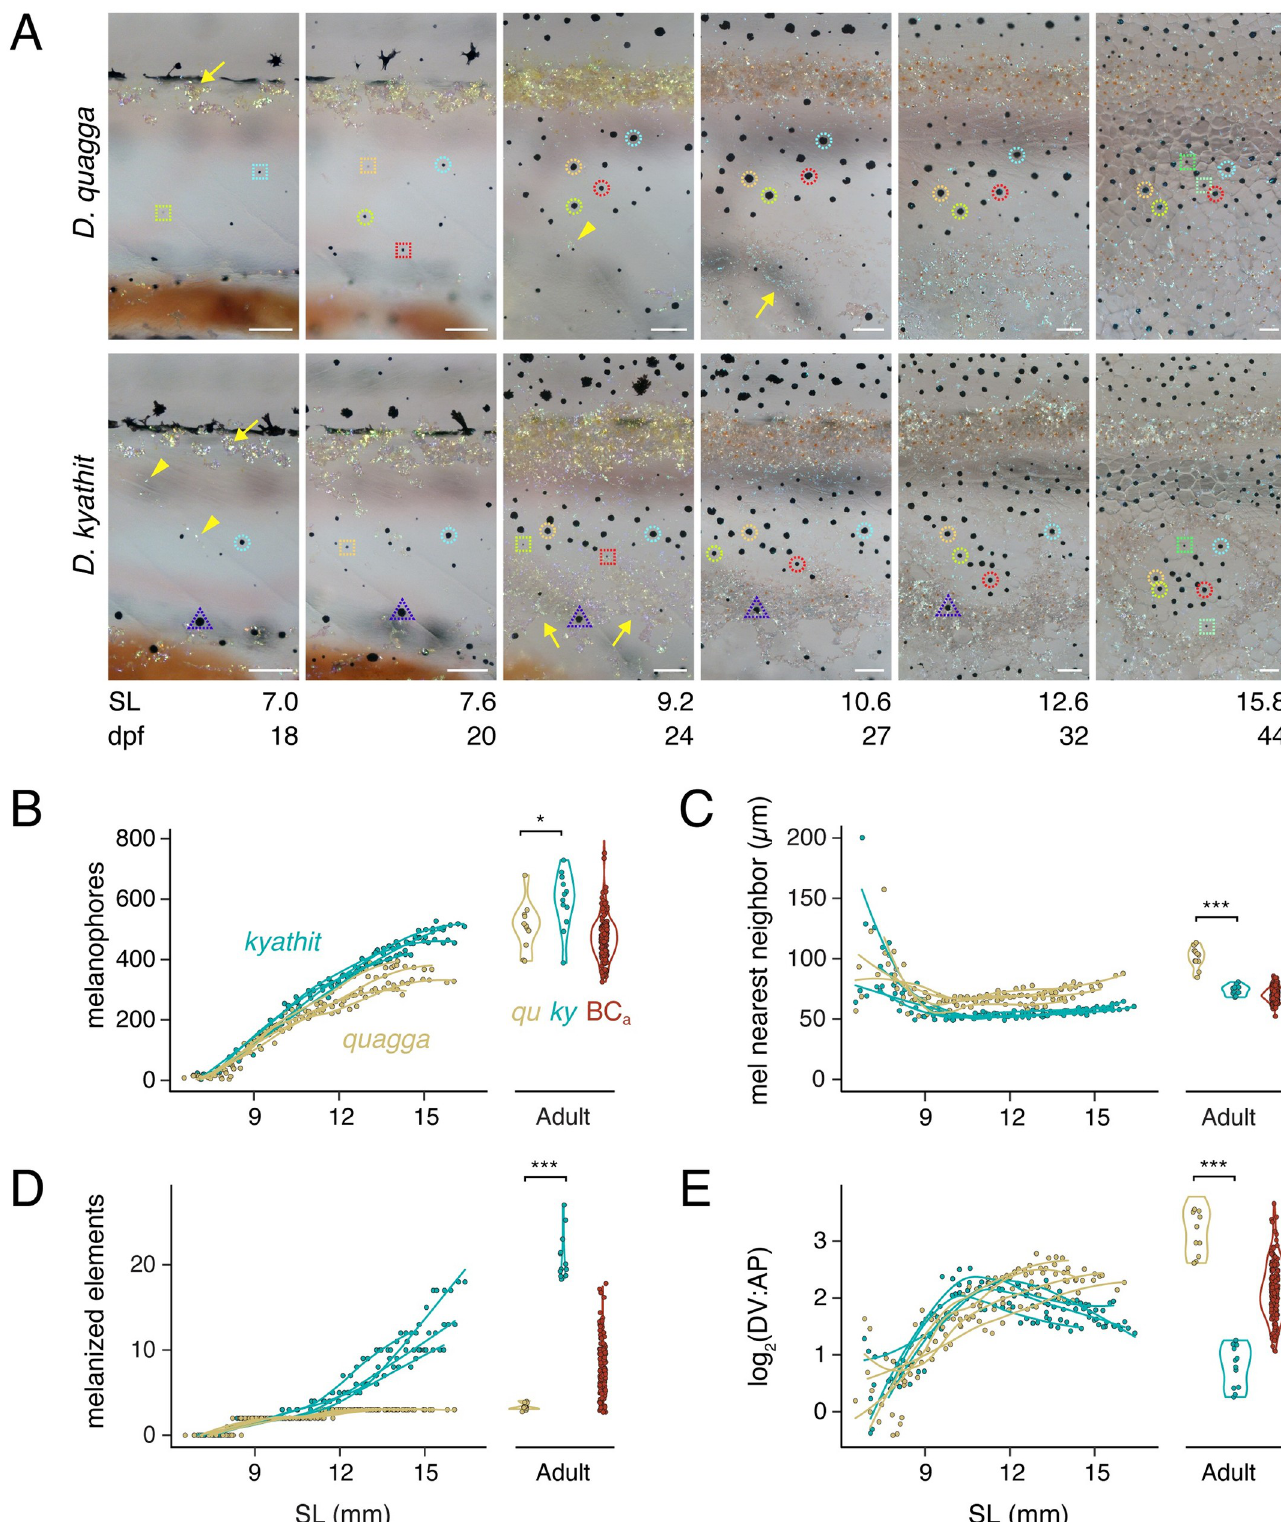
Fig 4. Pigment pattern development in D . quagga and D . kyathit . (A) Representative individuals imaged repeatedly during adult pattern formation. Images are aligned to show corresponding regions and rescaled to control for overall growth (frames and regions are selected from S1 Movie). Standard length (SL in mm)